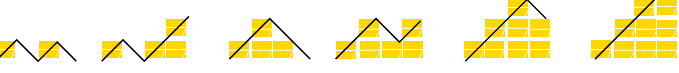
Fig. 2: Dyck paths of length 4 and their